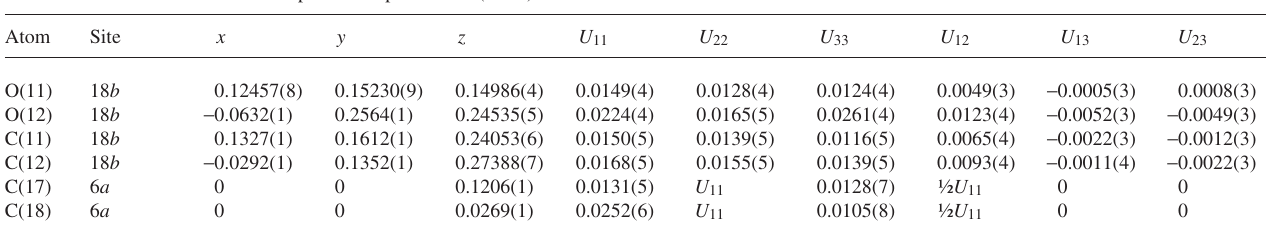
Table 3. Atomic coordinates and displacement parameters (in Å 2 )